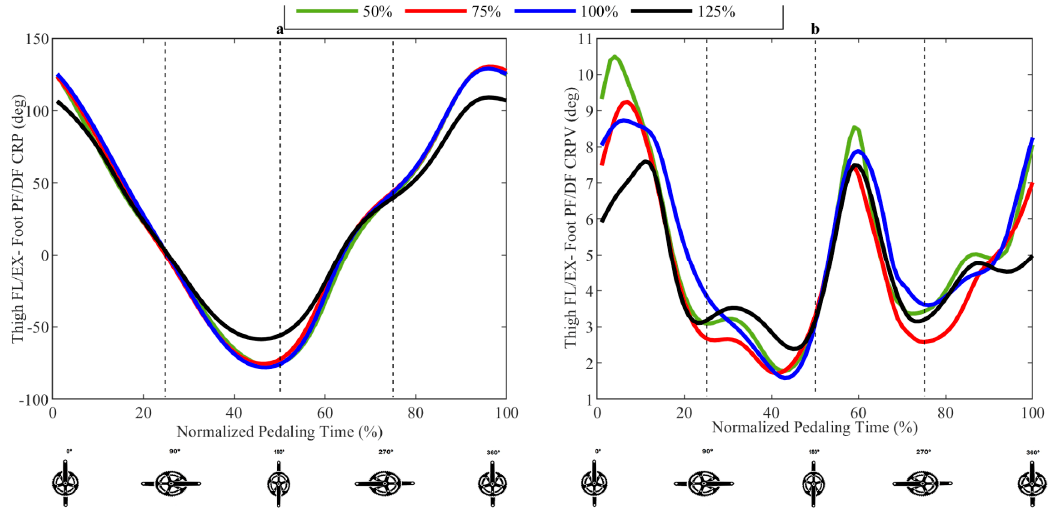
Figure 3. Thigh flexion/extension (FL/EX)-Foot plantarflexion/dorsiflexion (PF/DF) continuous relative phase (CRP) ( a ) and continuous relative phase variability (CRPV) ( b ) in different pedaling intensities .